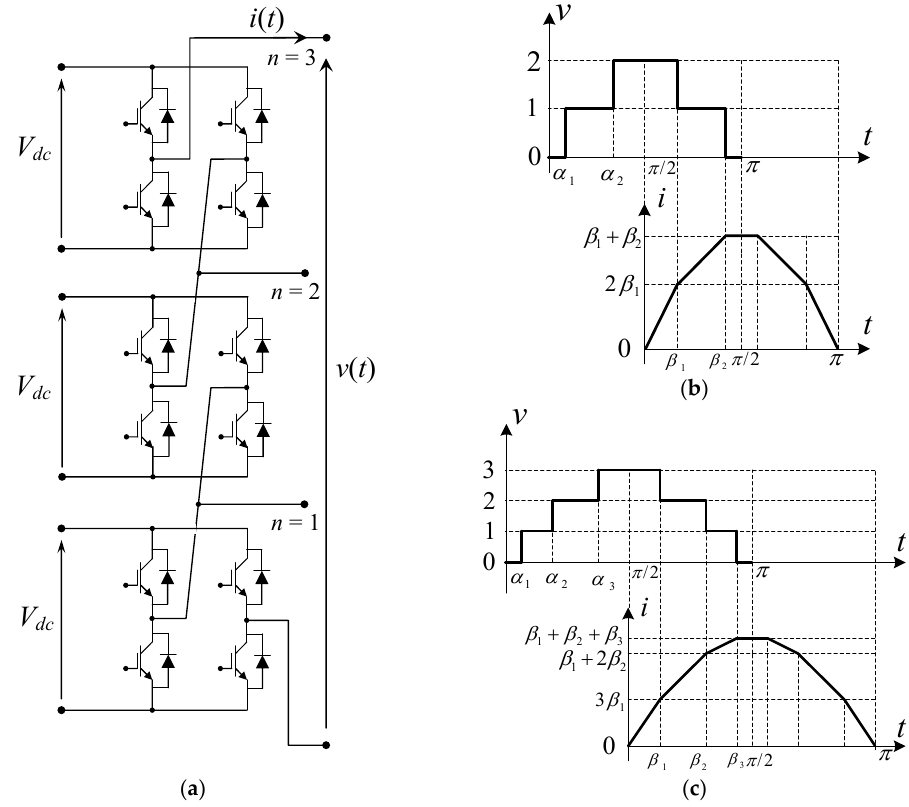
Figure 1. ( a ) Cascaded H-bridge inverter ( n = 1, 2, 3): voltage and current half-waves (p.u.) for staircase modulation in case of ( b ) five levels and ( c ) seven levels.